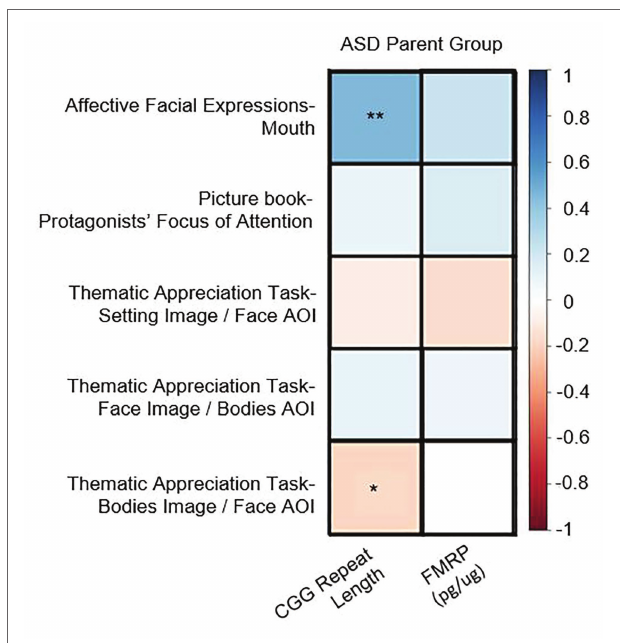
FIGURE 2 | Correlation matrix for genetics associations observed in the autism spectrum disorder (ASD) parent group across key areas of interest (AOI; * p < 0.05, ** p <